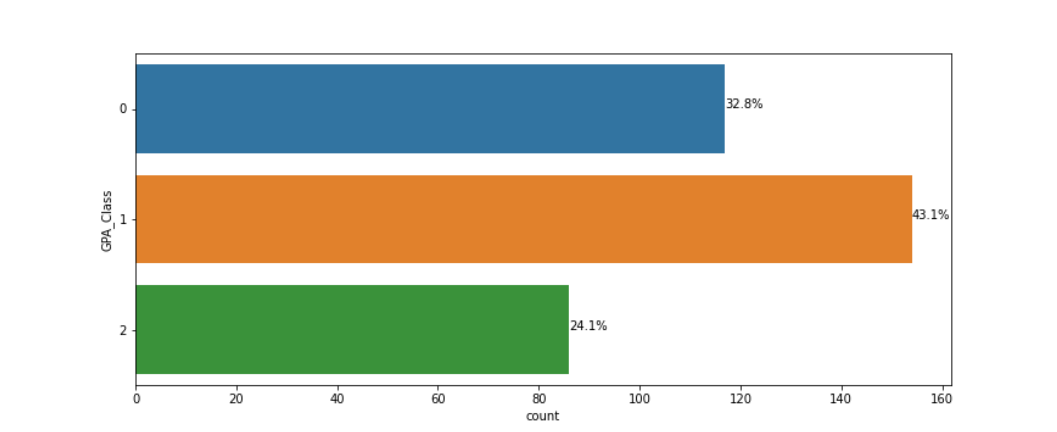
Figure 2. The bar chart showing the three classes in the target variable. The GPA Classes 0, 1, and 2 represent the classes Low GPA, Average GPA, and High GPA,